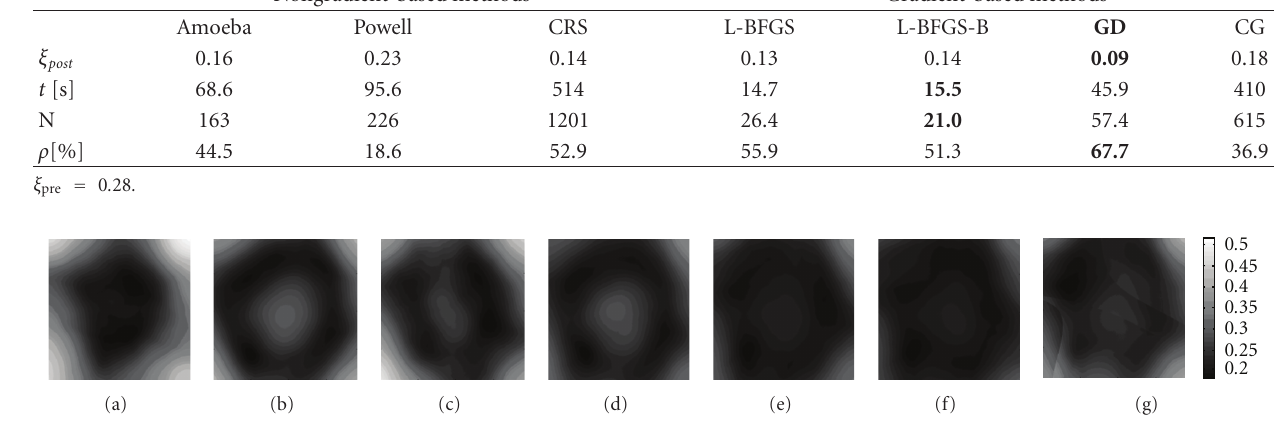
Table 1: Study of suitability of di ff erent optimizers for the task of optimization of Shannon’s entropy. The best values are highlighted. Nongradient-based methods